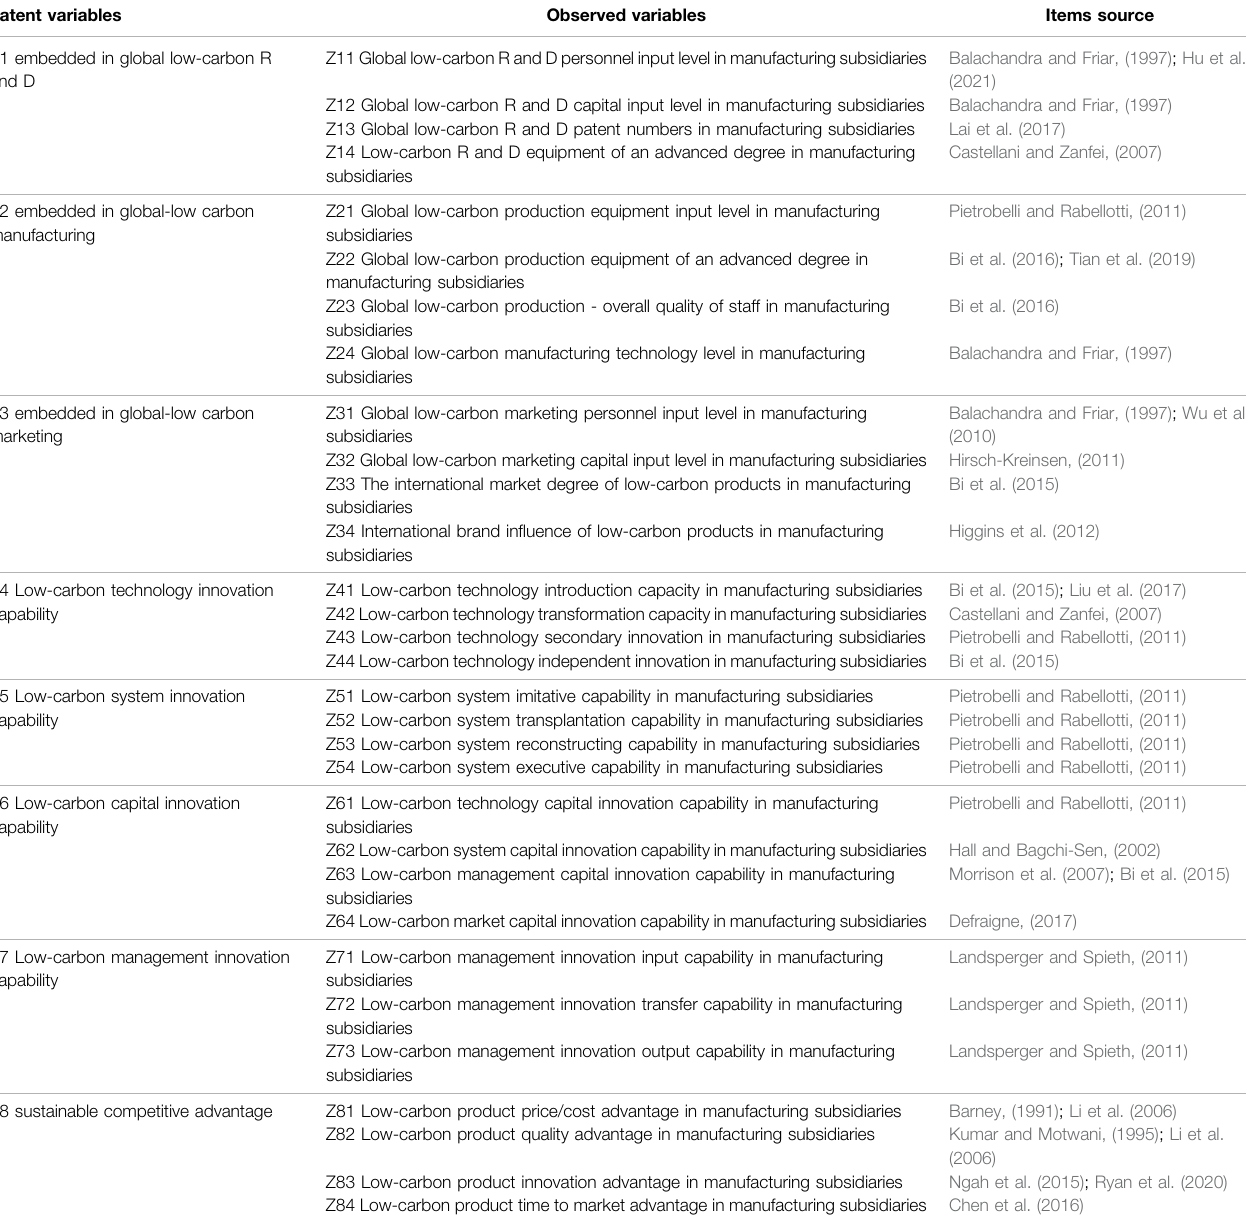
TABLE 1 | Index system of variables and its